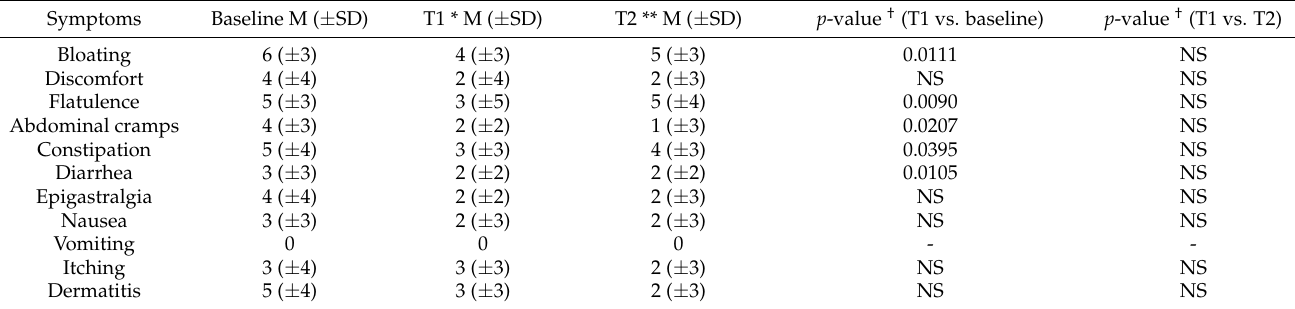
Table 2. Effects of cross interventions on patient-reported